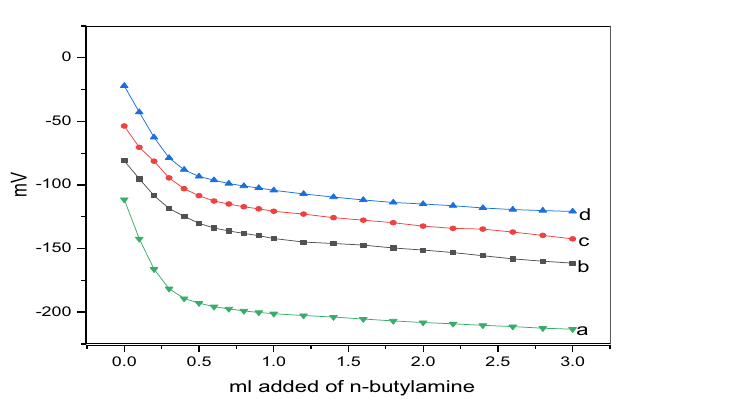
Figure 6. Acidity curve for ( a ) ZnO, ( b ) ZnO/5PVA, ( c ) ZnO/7PVA and ( d ) ZnO/10PVA calcined at 400